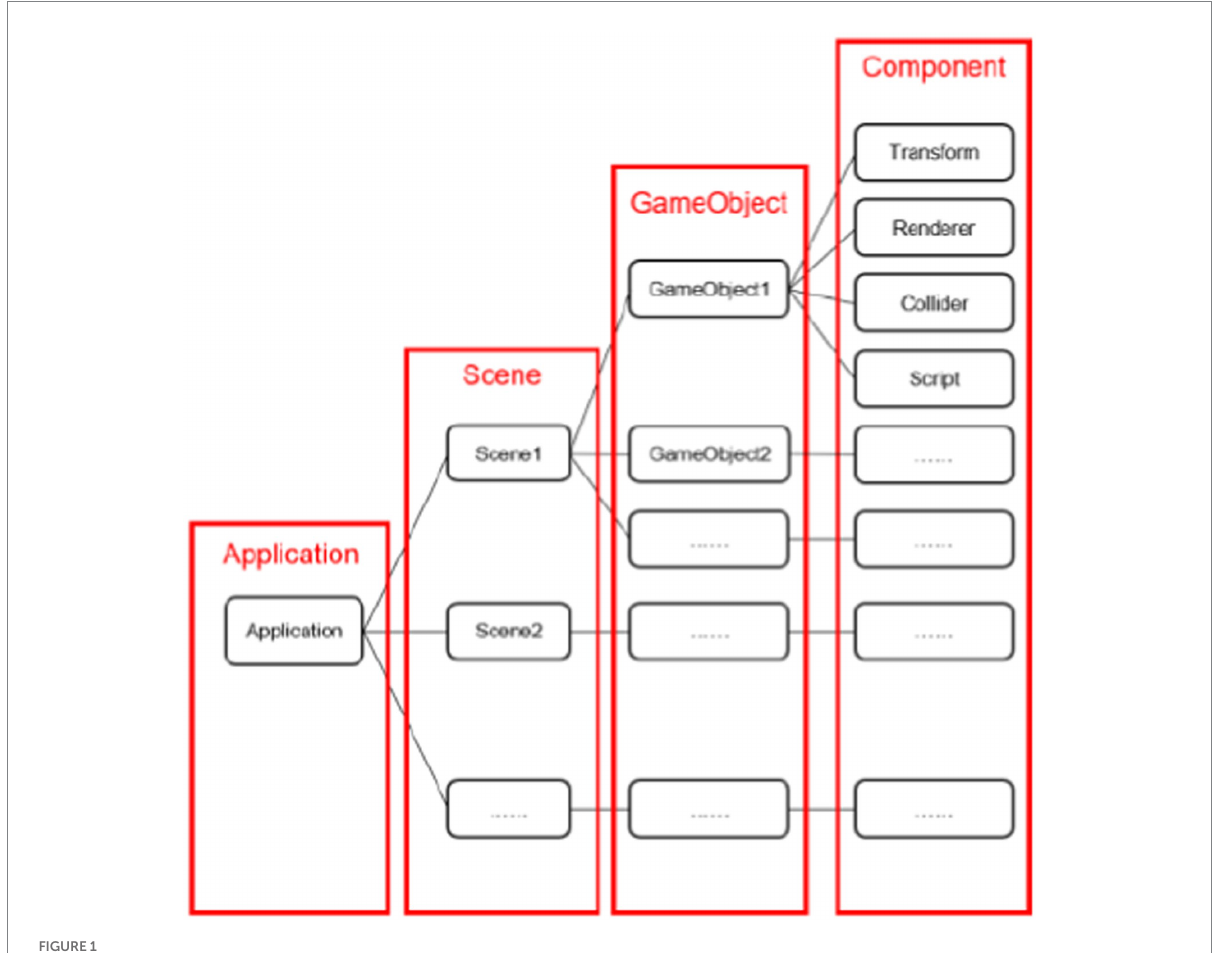
FIGURE 1 Development process of the game software.